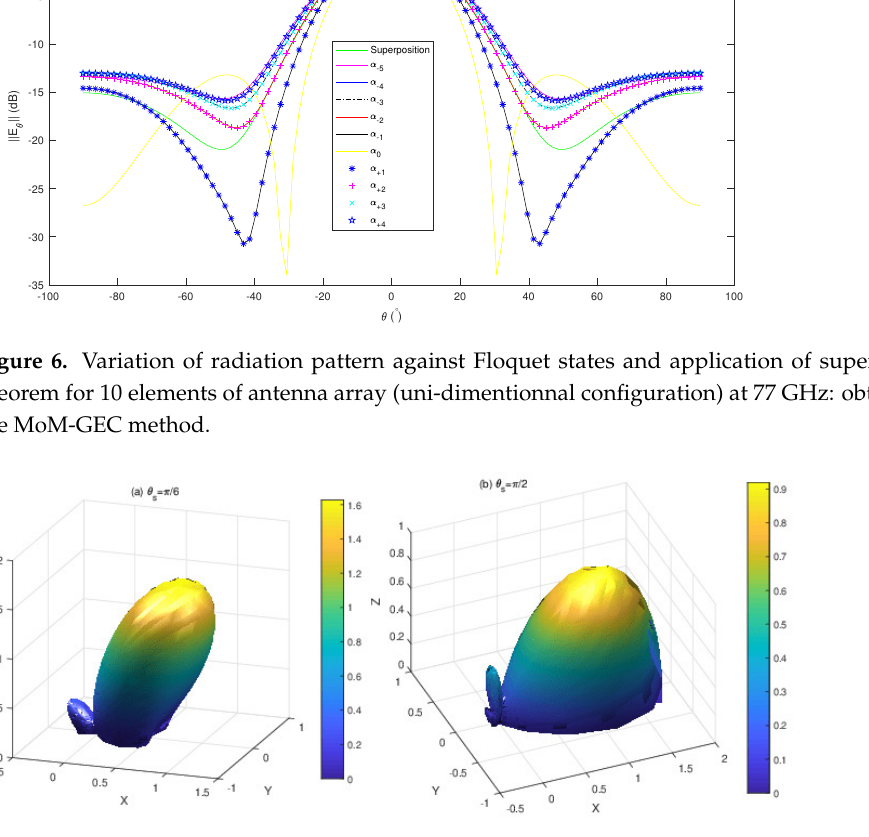
Figure 7. Variation of radiation pattern against Floquet states and application of superposition theorem for 100 elements of antenna array (uni-dimentionnal configuration) at 77 GHz: obtained by the MoM-GEC method. Table 1. Directivity versus some Floquet states (considering 100 antenna arrays) and the superposition theorem (or the modulation as explained in Formula (13), which transformed to study a finite array) for φ s = 0, θ s = 30 ◦ steering angles (used for 5G